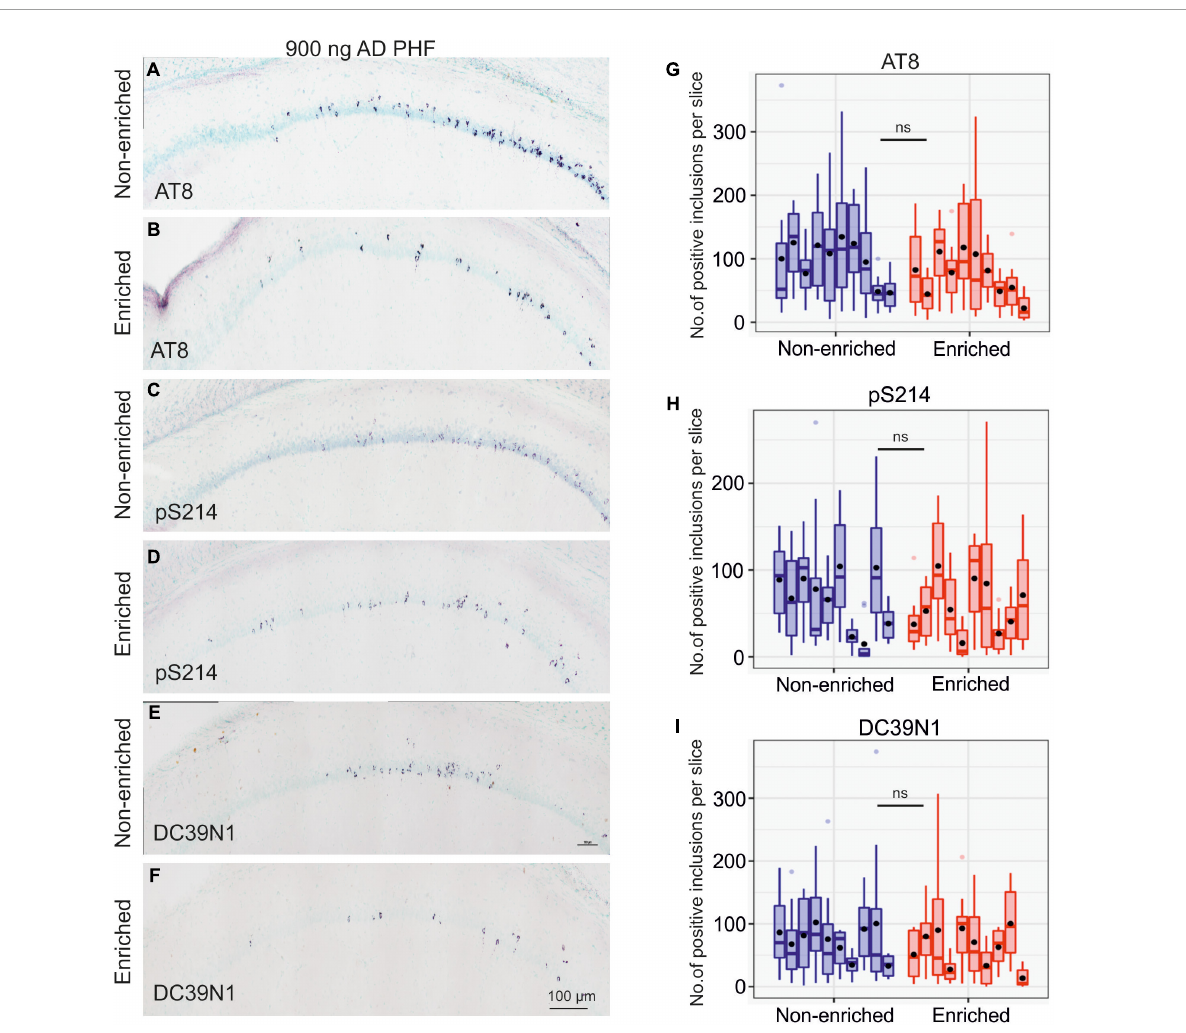
FIGURE5 Enriched environment is insufficient to halt tau pathology propagation in the group injected with a high dose of 900 ng AD PHF tau. (A–F) Representative sagittal sections of the hippocampus of SHR72 rats injected with 900 ng human AD PHF tau. For IHC staining phospho-tau dependent antibodies AT8 (A,B) , pS214 (C,D) and human tau specific antibody DC39N1 were used (E,F) . Scale bar: 100 µ m. (G–I) Quantitative analysis of tau pathology stained with phospho-tau dependent antibodies AT8 (G) , pS214 (H) , and human tau specific antibody DC39N1 (I) . No significant differences in the amount of accumulated tau pathology are seen between the groups (all p > 0.05). Each column denotes one animal. Boxes indicate median and quartiles for tangle counts per brain slice; whiskers indicate quartiles ± 1.5 × IQR. Black dots indicate arithmetic